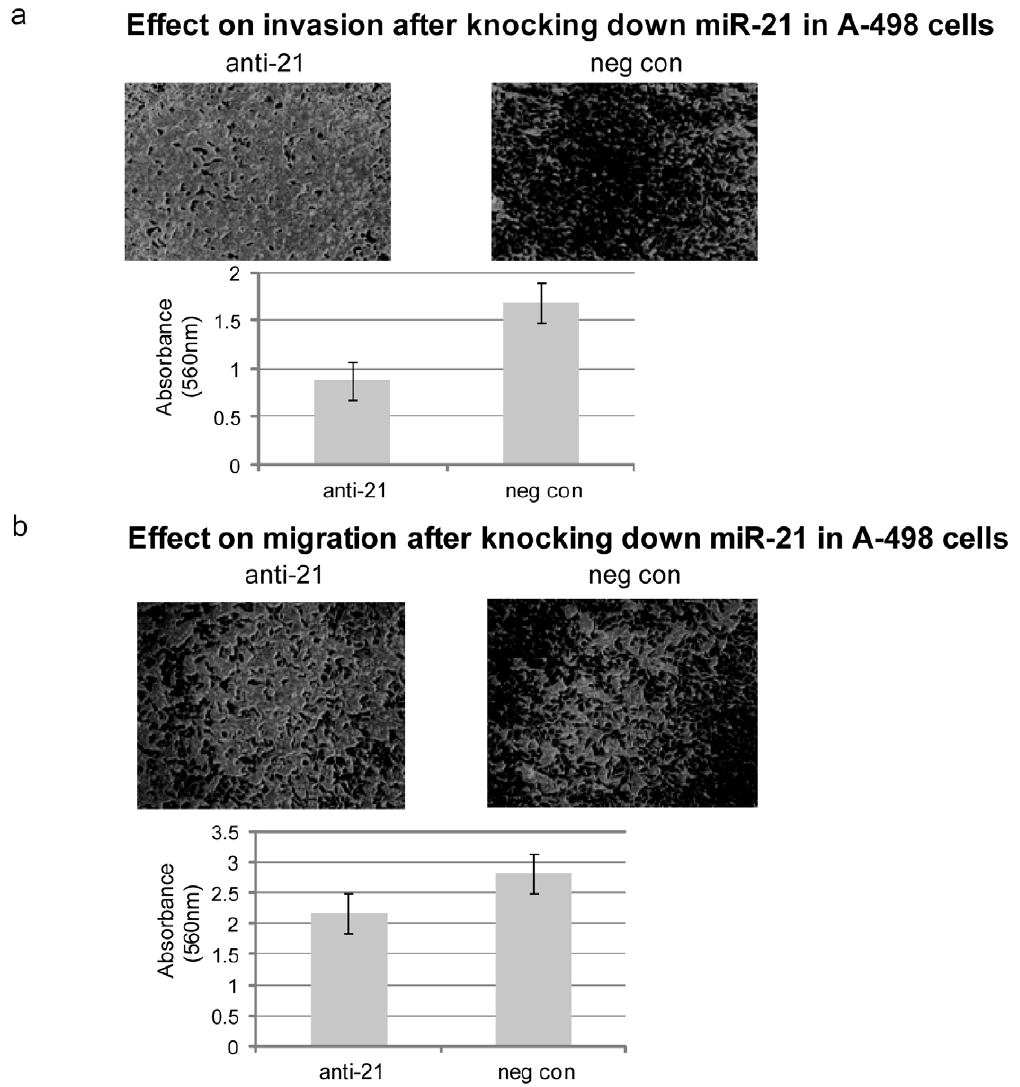
Figure 3. Effect on cell invasion and migration on A-498 cells after miR-21 inhibition. (a) Effect on cell invasion: Invasive properties of A- 498 cells were decreased after the inhibition of miR-21 as compared to the negative control, Stained A-498 cells (Magnification-40 6 ); Absorbance at 560 nm (p value 0.026). (b) Effect on cell migration: Migratory properties of A-498 cells were also decreased after the inhibition of miR-21 as compared to the negative control, Stained A-498 cells (Magnification-40 6 ); Absorbance at 560 nm (p value 0.016).